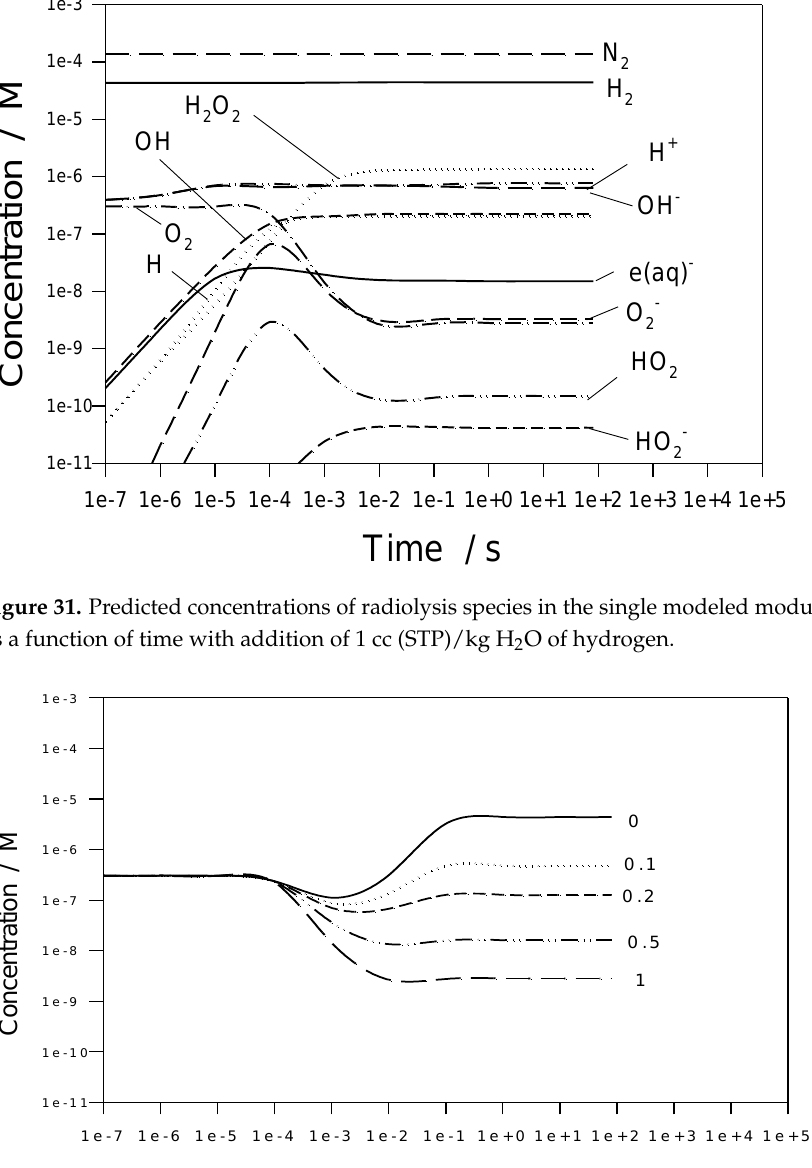
Figure 33. Predicted concentration of hydrogen peroxide in the single modeled module as a function of time for different initial concentrations of hydrogen in cc (STP)/kg H 2 O. Figure 34 shows predicted concentrations of metal-containing species as a function of time, assuming initial conditions are [Cu 2+ ] = 10 ppb, [Fe 2+ ] = 10 ppb, and [Cu + ] = [Fe 3+ ] = 0 [1,35]. Because of the presence of added hydrogen [1 cc(STP)/kg H 2 O], the most highly oxidized species (Cu 2+ , Fe 3+ ) tend to be reduced to Cu + , Fe 2+ , respectively, as the system achieves a steady state. The final concentrations reflect the redox potential of the coolant ( E O/R ), which is analogous to the ECP, except the metal substrate is inert (and hence is measured using a Pt indicator electrode). The more negative the value of E O/R , the more reducing is the environment and, hence, the greater is the driving force for the reduction of species to lower oxidation states. Figure 35 shows concentrations of metal-containing species for initial conditions of [Cu + ] = 10 ppb, [Fe 3+ ] = 10 ppb, and [Cu 2+ ] = [Fe 2+ ] = 0 [1,35]. Note that the calculations displayed in Figures 34 and 35 differ in the initial concentrations of the metal species. Again, the hydrogen addition results in the reduction of Cu 2+ and Fe 3+ to Cu + , and Fe 2+ , respectively. These findings have important consequences with respect to the corrosion of structural materials in the IBED PHTS. For example, a lower